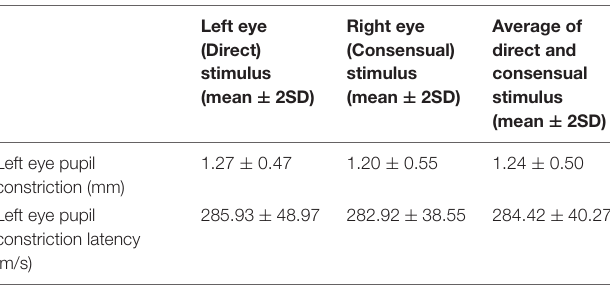
with change in sal-T [ r s (11) = 0.14, p = 0.32], change in